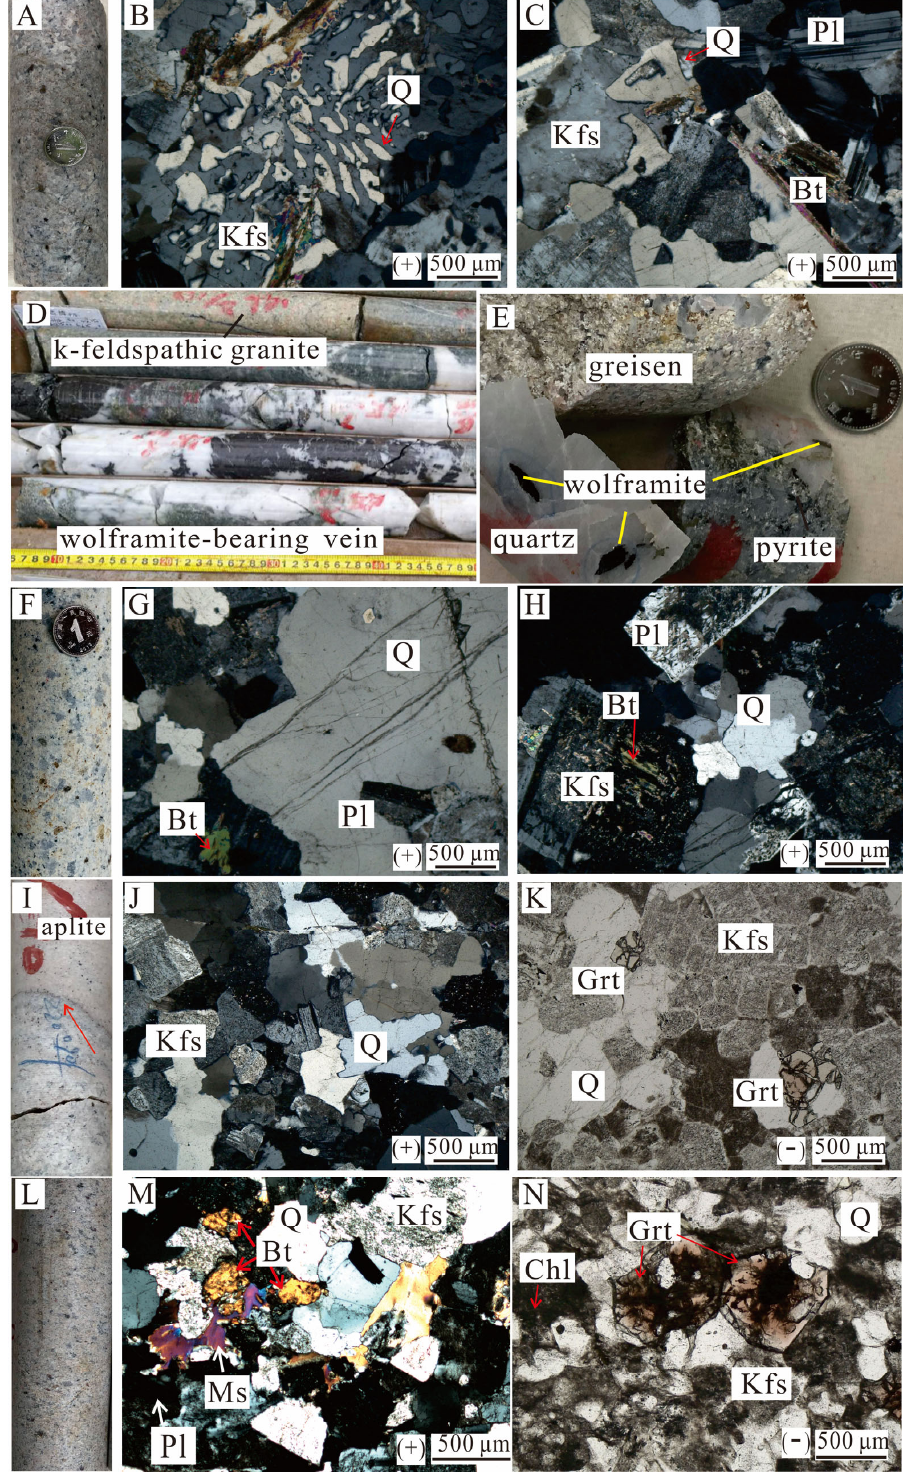
Figure 3. Photographs showing mineral composition of granites associated with the Jinzhuping ( A – K ) and Changkeng ( L – N ) ore deposits. ( A–C ) Medium- to coarse-grained biotite granite; ( D–E ) potash feldspathization, greisenization, and wolframite-quartz vein in the main-phase granite; ( F–H ) porphyritic biotite granite; ( I–K ) aplite; ( L–N ) mineral composition of biotite granite, and the K-feldspar replaced by chlorite. Q—quartz; Pl—plagioclase; Kfs—potassium feldspar; Bt—biotite; Ms—muscovite; Grt—garmet;